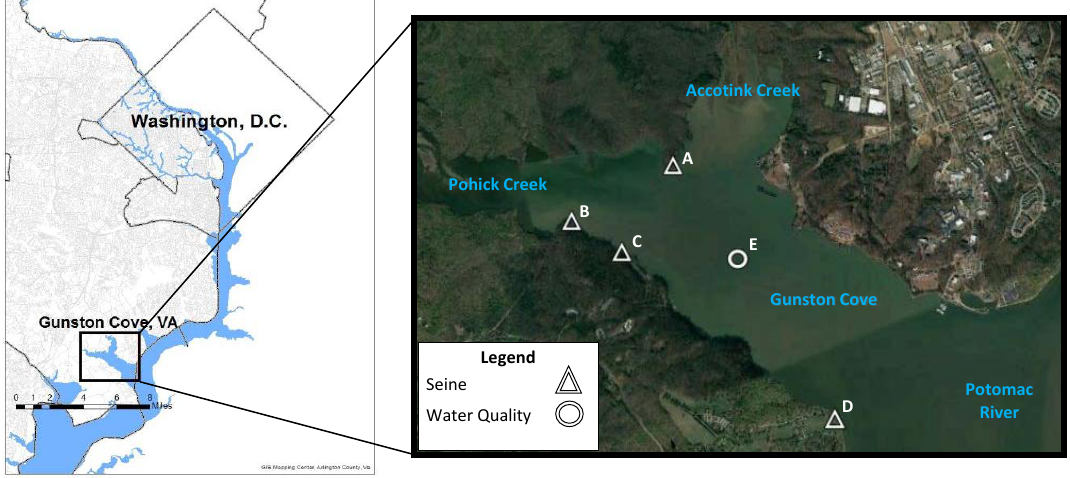
Figure 1. Location of study area and sampling sites. The sampling sites of seine hauls ( A – D ) and water quality ( E ) are indicated in the figure.